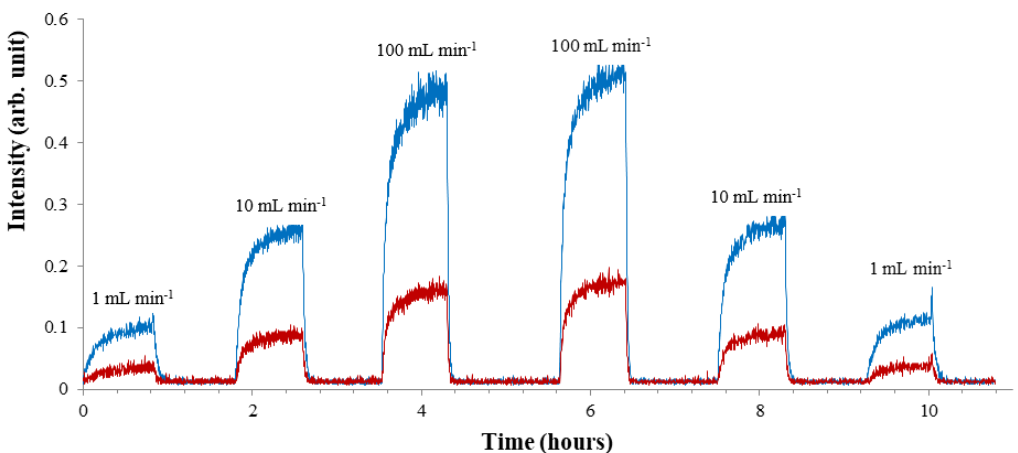
Figure 2. Influence of flow rate on Membrane Introduction Mass Spectrometry (MIMS) signal intensity. Ions with m / z values of 51.995 (NH 335 Cl + : Blue) and 53.992 (NH 337 Cl + : Red) were selected to monitor monochloramine. Experiments were conducted in duplicate.